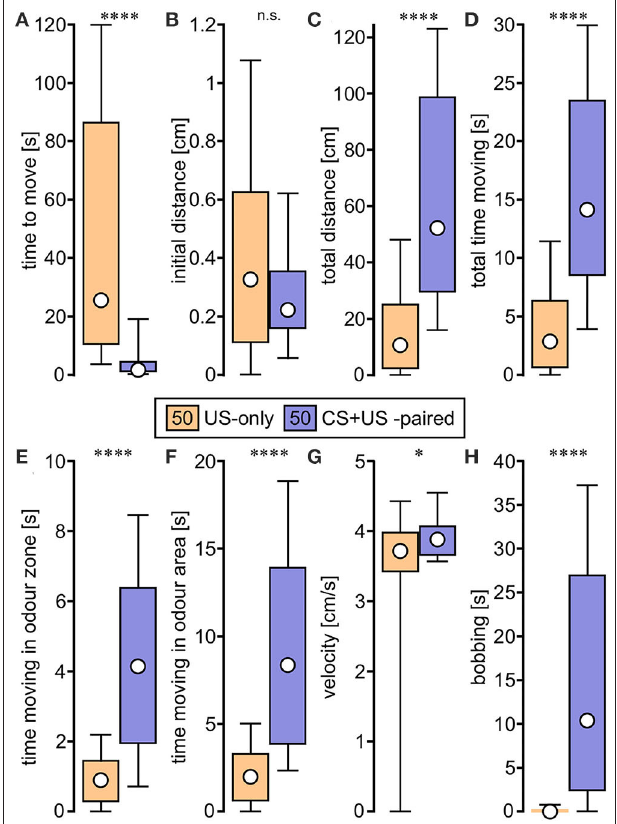
FIGURE 2 | Box plots of variables extracted from video tracked odour responses and used for binary regression analysis. The animals were trained in the single odour (absolute) conditioning paradigm ( Figure 1 ) and received either US-only (orange) or CS + US-paired (purple; circle: median; box: interquartile range; whiskers: 10th and 90th percentile; N = 50 for each group). (A) Time to move . (B) Initial distance . (C) Total distance . (D) Total time moving . (E) Time moving in odour zone . (F) Time moving in odour area . (G) Velocity . (H) Bobbing . Asterisks indicate significant differences: Mann-Whitney U -test; * p < 0.05; **** p < 0.0001; n.s., not